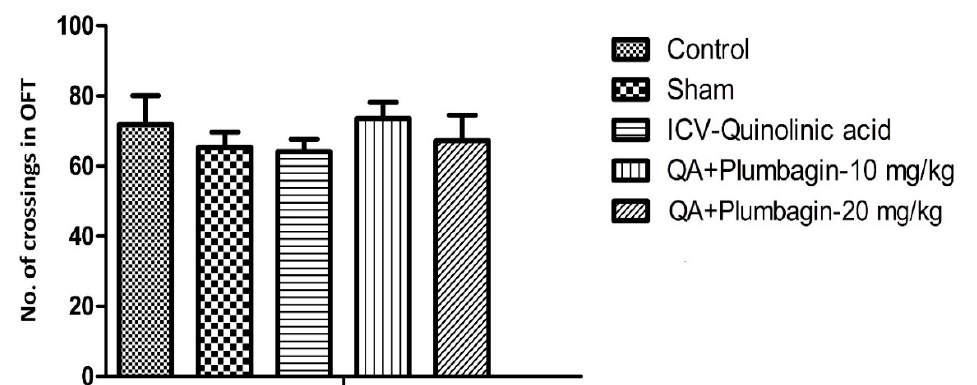
Figure 5. Effect of plumbagin on QA-induced effect on number of crossings in OFT through the Open Field Test. Data represent no significant effect when compared to control and the ICV QA- induced group.